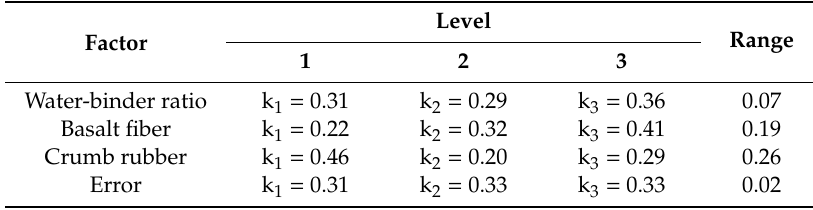
Table 12. Range analysis for RCH